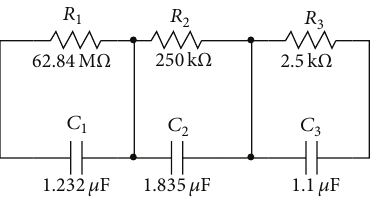
Figure 3: The unit circuit of 1 /𝑠 0 . 9